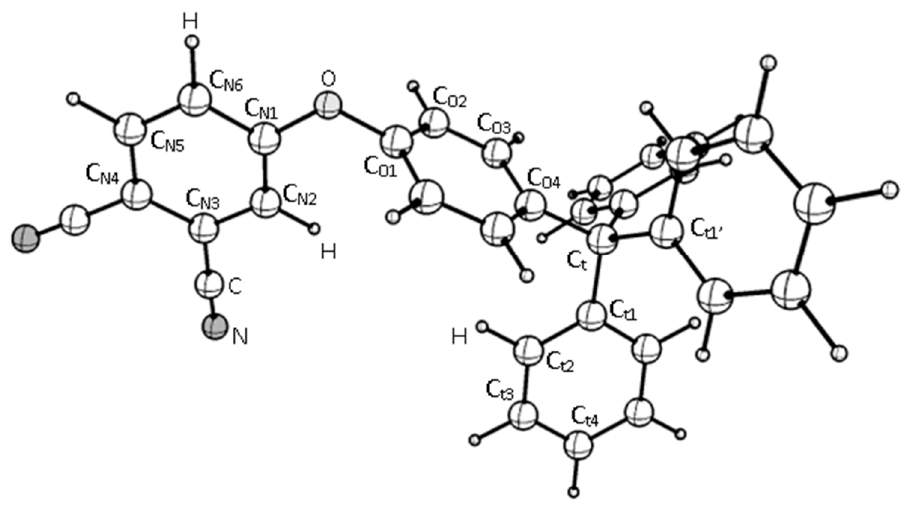
Figure 1. Atom numbering in the TPPN molecule.